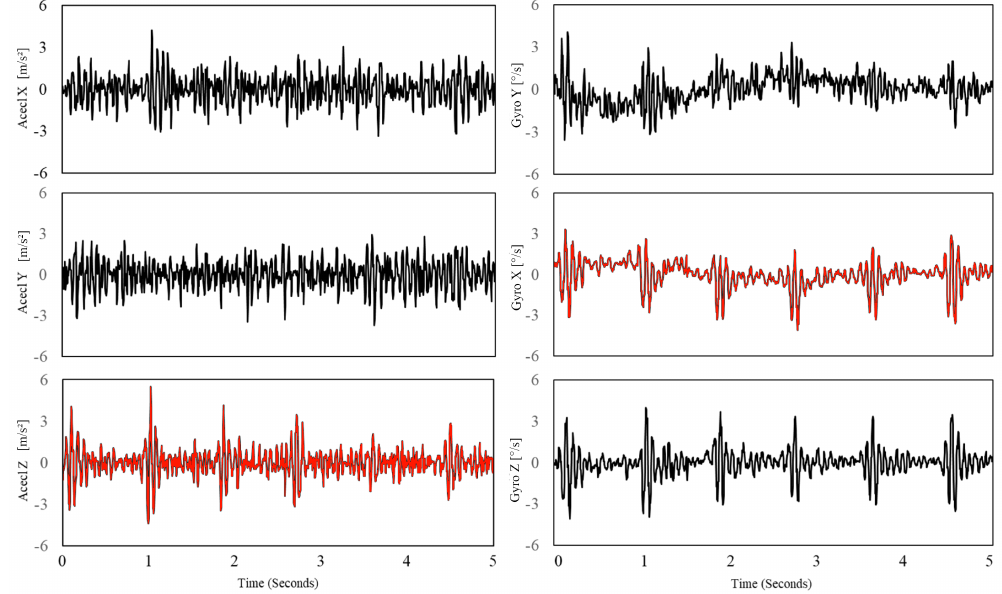
Figure 3. SCG signal ( left ) and GCG signal ( right ) in three axes after applying Savitzky-Golay filter to remove motion artifacts. Typical axes of seismocardiogram (z-axis) and gyrocardiogram (y-axis) are shown as a red line. Modified version of the graph derived from the article [37] by Lee et al. under the license CC-BY